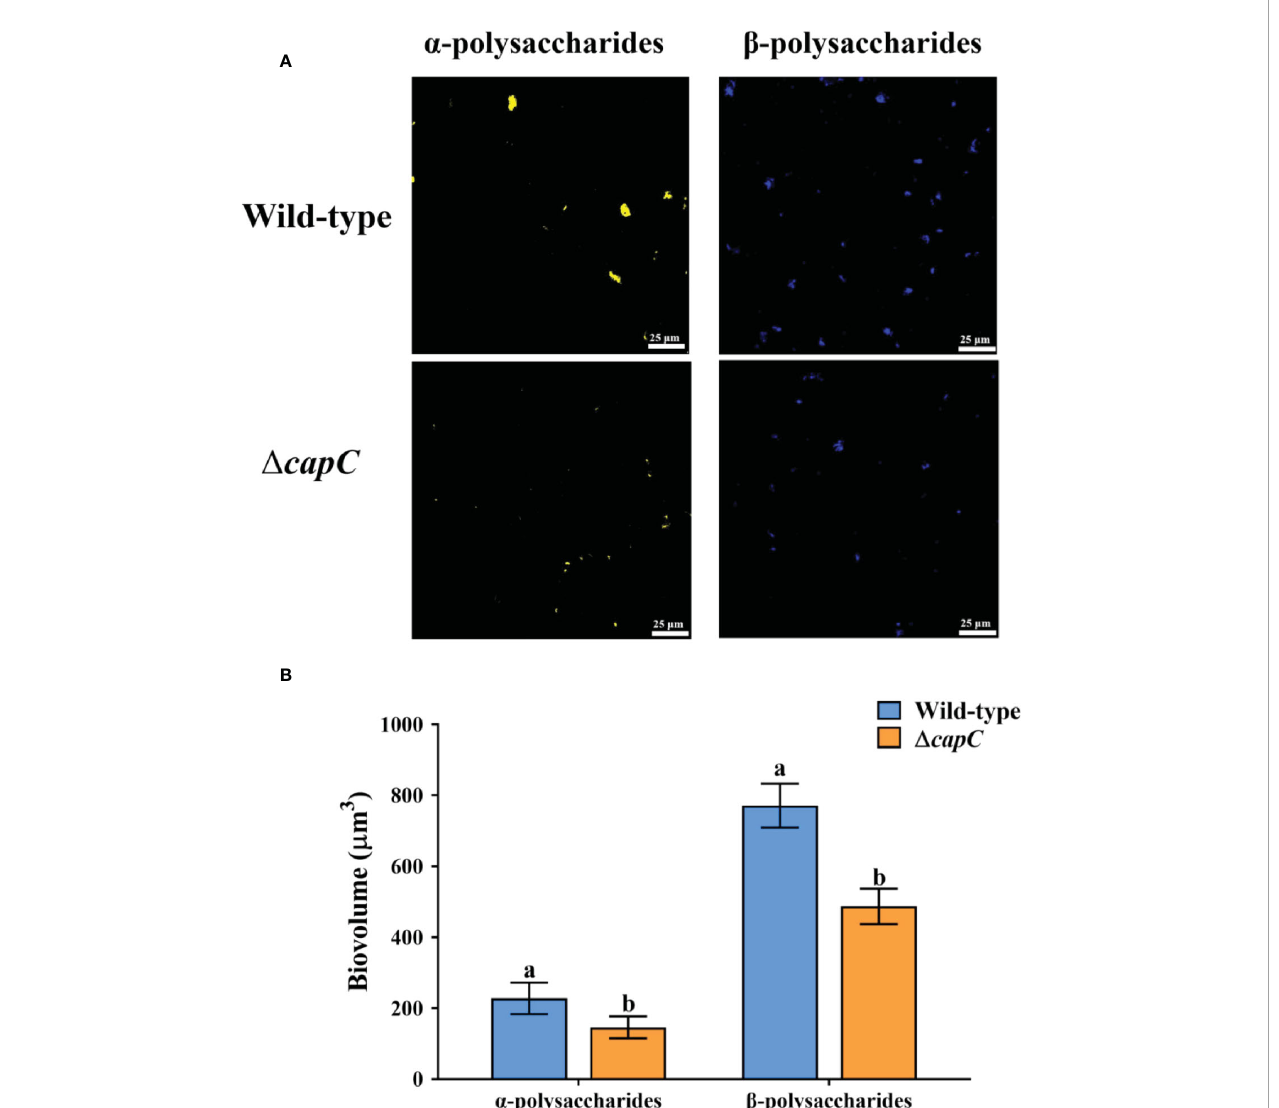
FIGURE 6 The CLSM analysis of exopolysaccharide in wild-type and D capC bio fi lms. (A) Distribution of extracellular polysaccharides in two experimental bio fi lms. (B) Analysis of